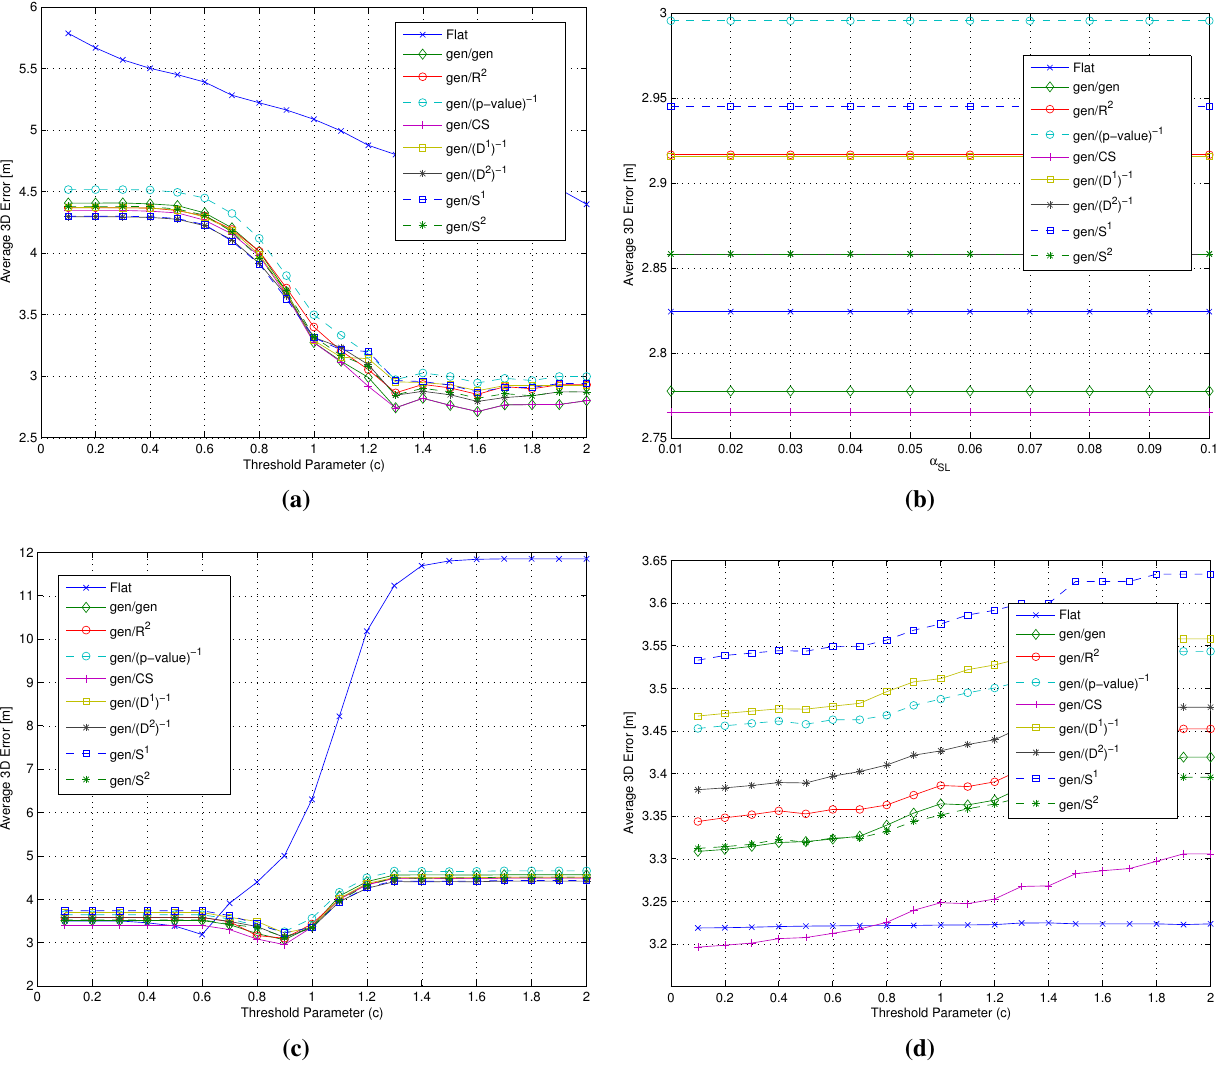
Figure 8. Impact of the m combinations; ( b ) flat vs. gen/ m combinations; ( d ) flat vs. gen/ m